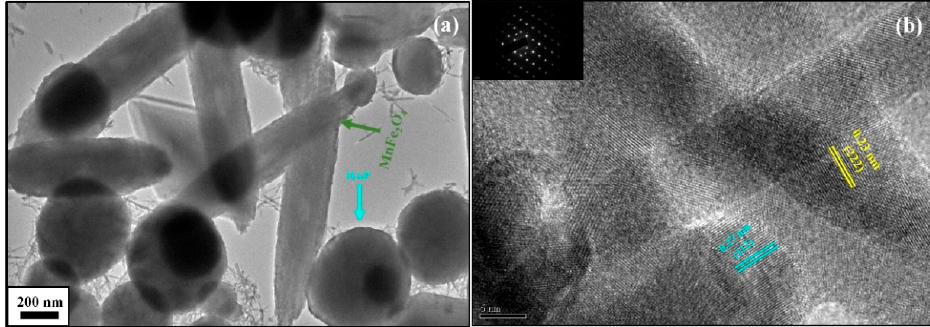
Figure 4. ( a ) TEM and ( b ) HR-TEM spectra of HAP-MnFe 2 O 4 nanocomposite; inset shows SAED pattern.